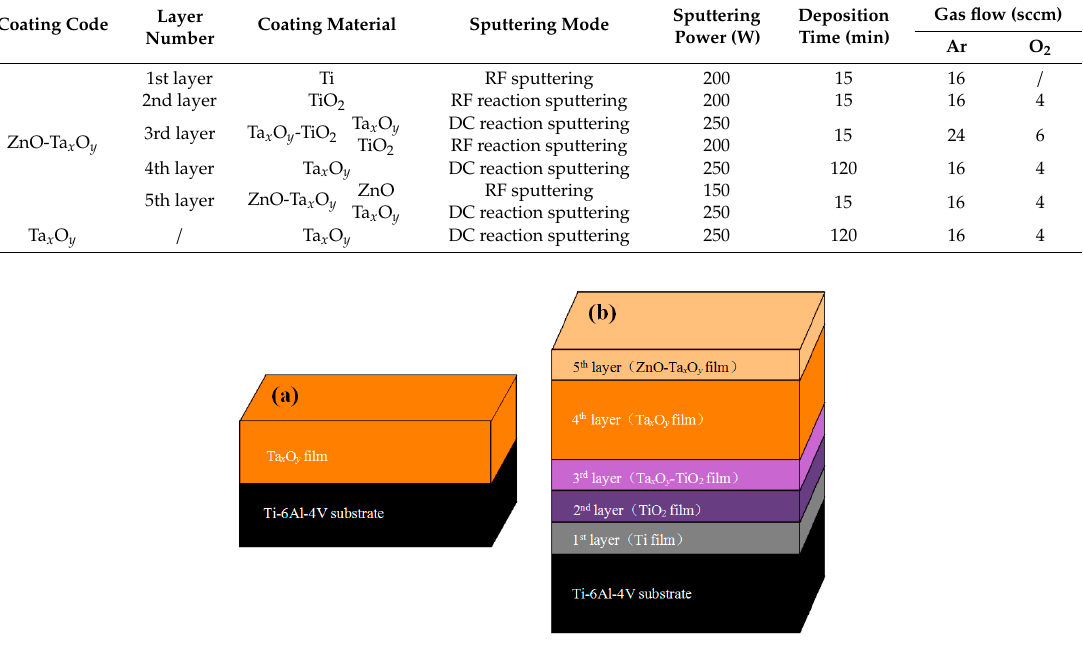
Figure 1. Schematic representation of ceramic composite coating structure: ( a ) Ta x O y coating, ( b ) ZnO-Ta x O y coating.